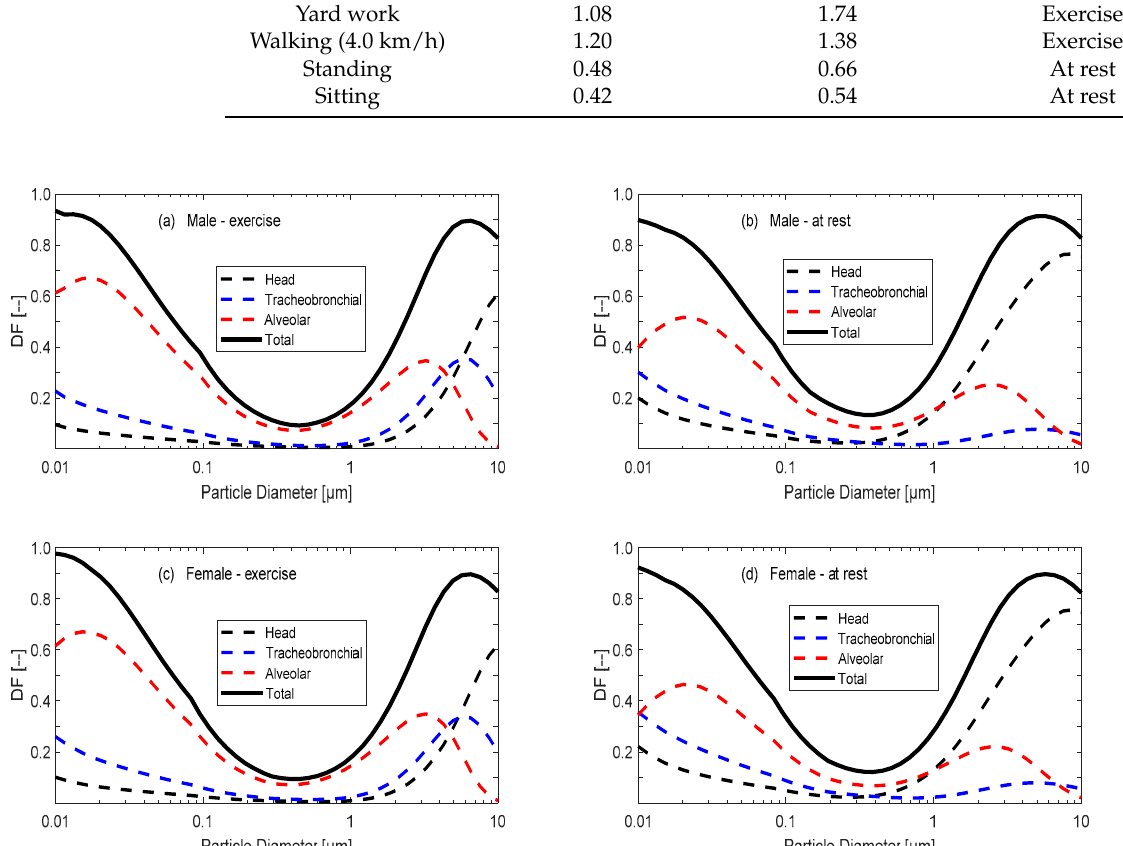
Table 1. Minute ventilation (volume of air breathed), V E (m 3 /h), for adults according to Holmes [32]. The last column indicates the deposition fraction ( DF ) curve used for that activity (Figure 2).